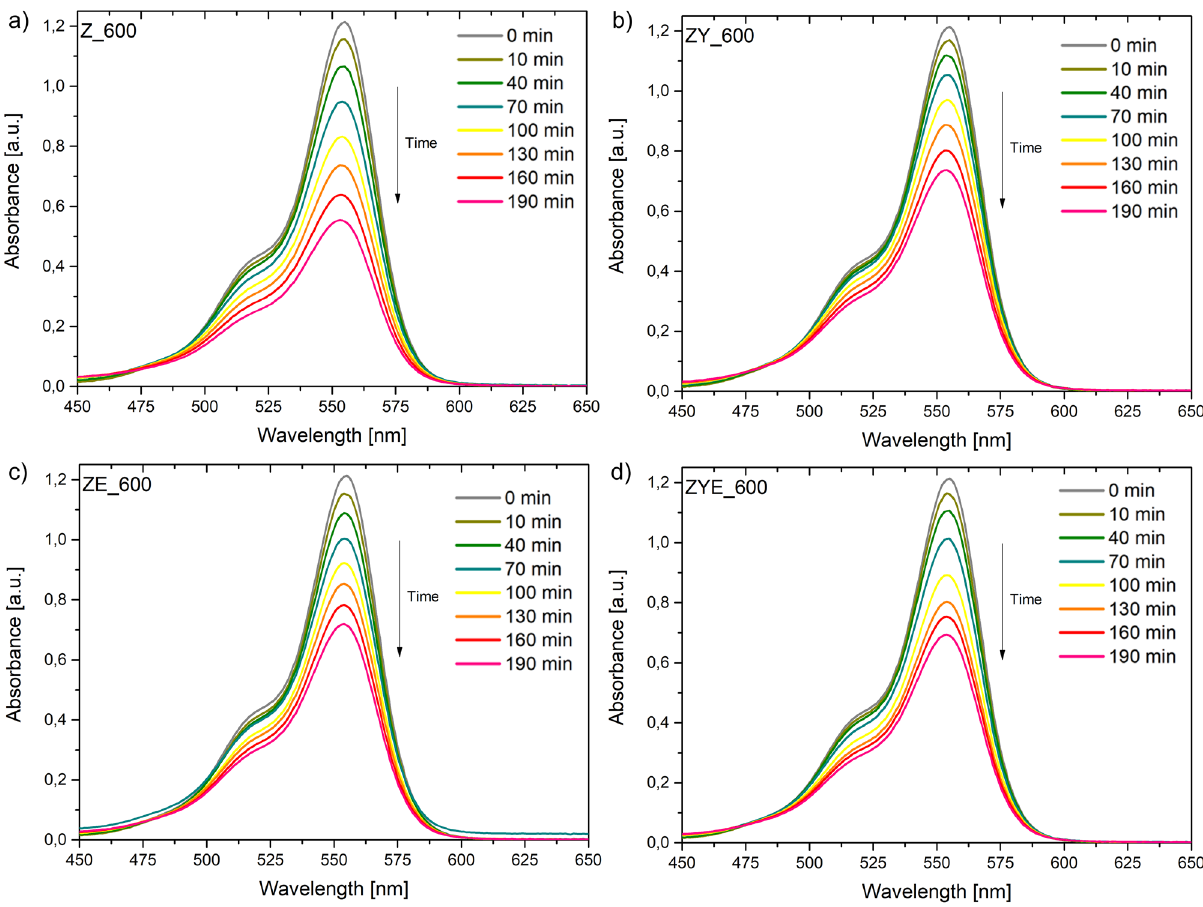
Figure 9. Dependence of absorption as a function of exposure time to solar radiation of the aqueous RhB solution in the presence of a photocatalyst in the form of a thin layer: ( a ) ZnO, ( b ) ZnO/Yb 2 O 3 , ( c ) ZnO/Eu 2 O 3 , ( d ) ZnO/Yb 2 O 3 /Eu 2 O 3